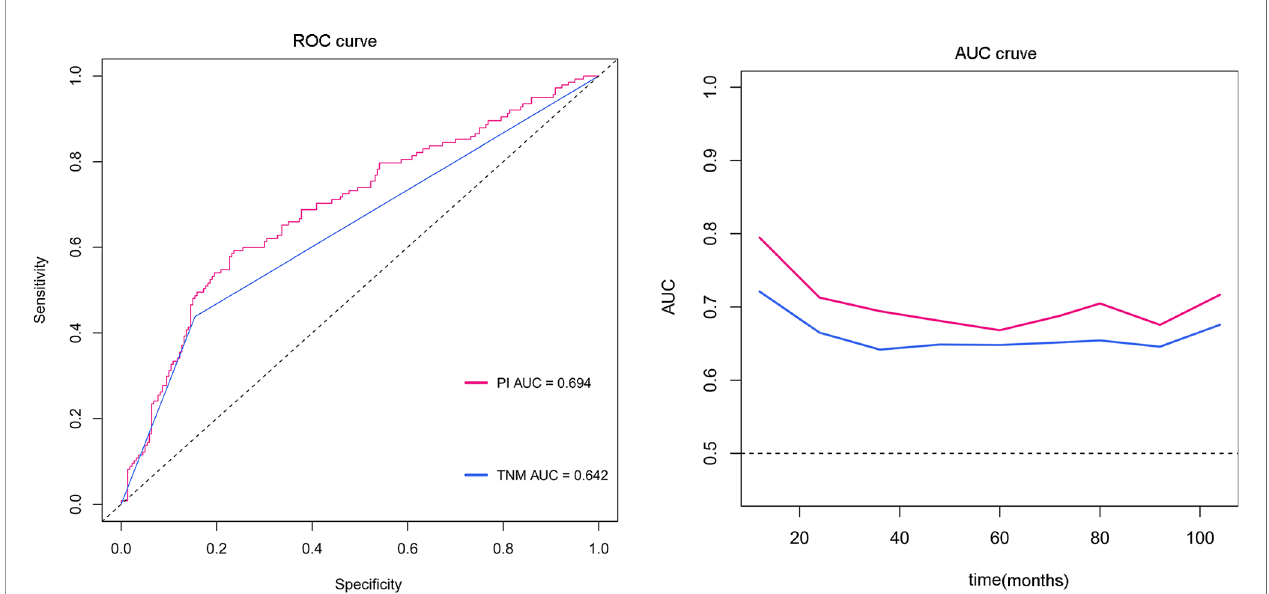
FIGURE 9 | ROC and time-dependent AUC curves for the nomogram. The red line represents the prognostic nomogram, and the blue line represents the TNM staging system alone.